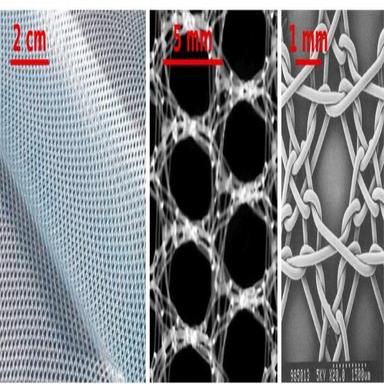
Illustration of the different scales and complex structure of knitted hernia meshes.